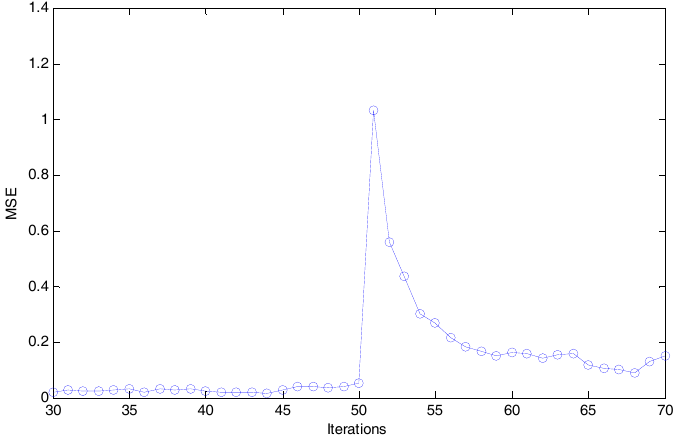
Figure 1. The mean square errors (MSEs) of distributed mixed H 2 /H ∞ fusion estimator (DMHFE).